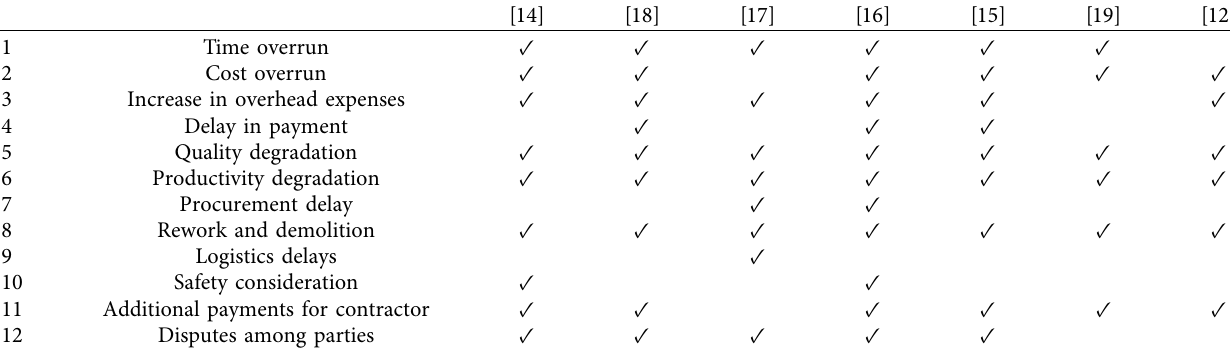
Table 1: )e effects of change orders from reviewed